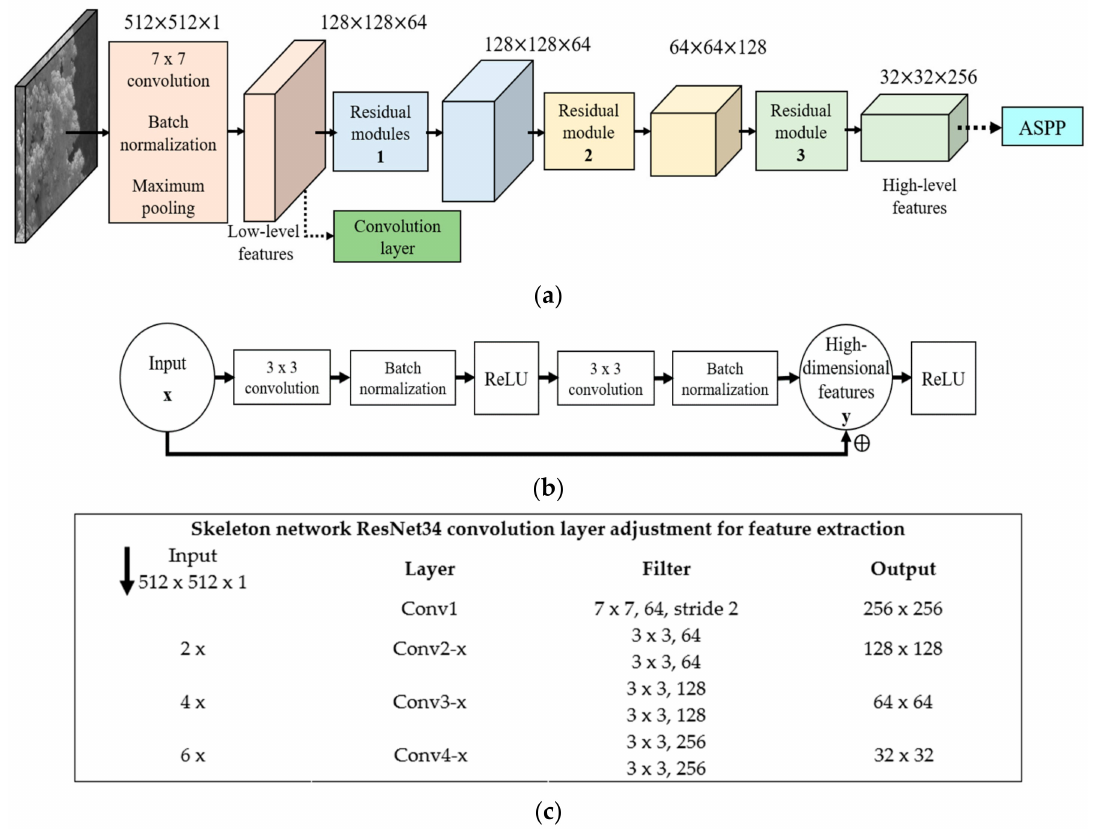
Figure 2. Components of DeeperLabC: ( a ) ResNet34 framework; ( b ) Residual module structure; ( c ) Details of convolution layers of adjusted ResNet34 for feature